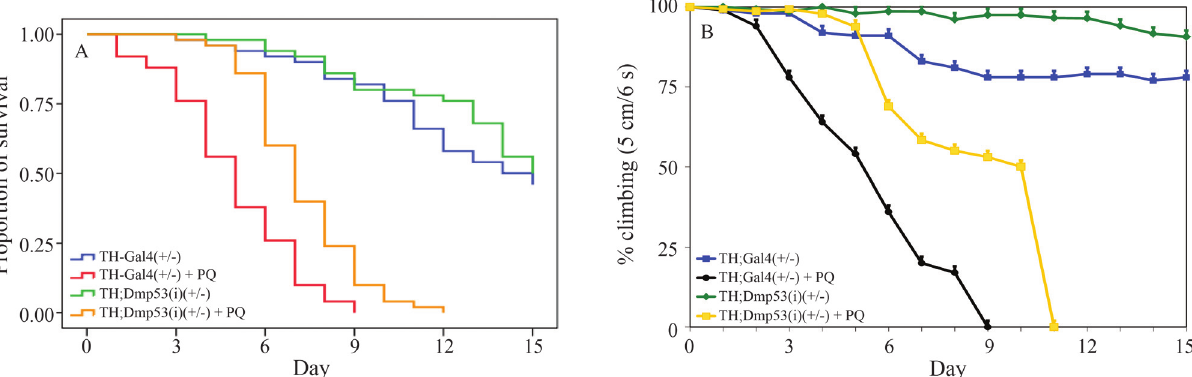
Figure 2 - Dmp53 gene knockdown increases life span and locomotor activity in Drosophila melanogaster exposed to paraquat. Female flies (n = 50 per treatment) were treated as described in Materials and Methods . The graphs show that the proportion of survival (A) and climbing performance (B) were significantly increased in TH-Gal4 +/- , UAS-Dmp53 RNAi +/- gene knockdown flies compared to the TH-Gal4 +/- fly line (control). Statistical comparisons between untreated and treated flies showed: (A) a p < 0.05 by log-rank test and (B) a p < 0.05 by (cid:2) 2 test. Comparisons between treated gene knockdown flies and the TH-Gal4 +/- fly line showed statistical significance.